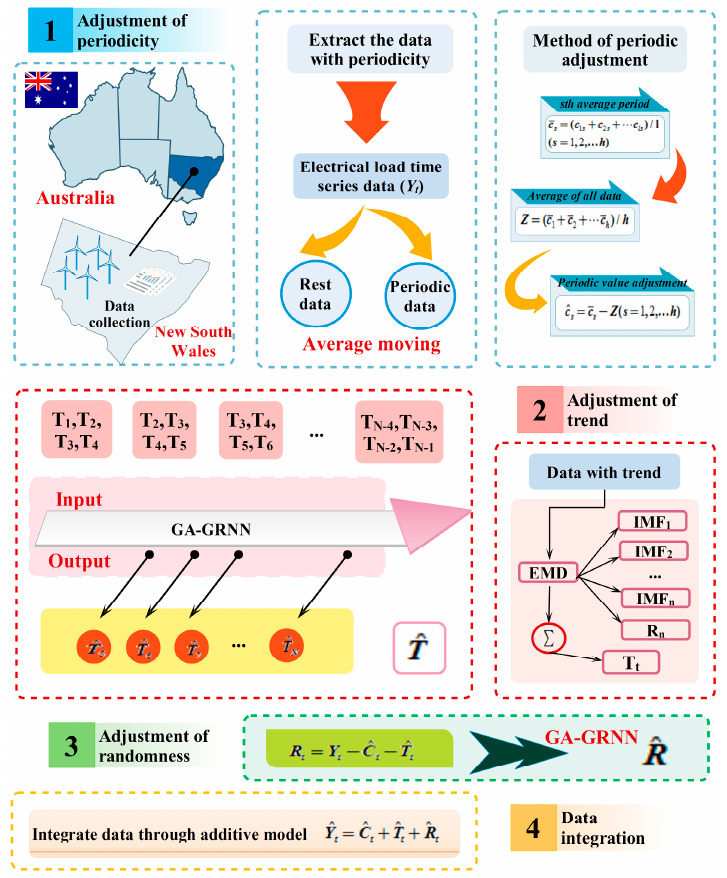
Figure 2. The process of electrical load forecasting for New South Wales.